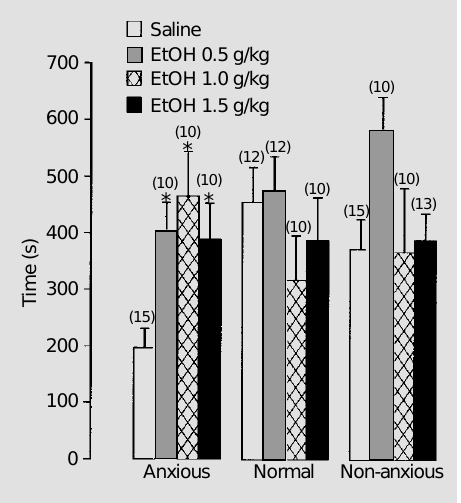
Figure 1 - Mean time (s) spent on the test day in the previously drug-paired compartment of the place preference apparatus. Place conditioning sessions were held for 4 days for anx- ious, non-anxious and normal rats injected ip with saline or ethanol (EtOH) (0.5, 1.0 or 1.5 g/ kg). Data are reported as the mean ± SEM. Numbers in pa- rentheses indicate the size of the groups. *P £ 0.05 compared to the control group (Newman- Keuls